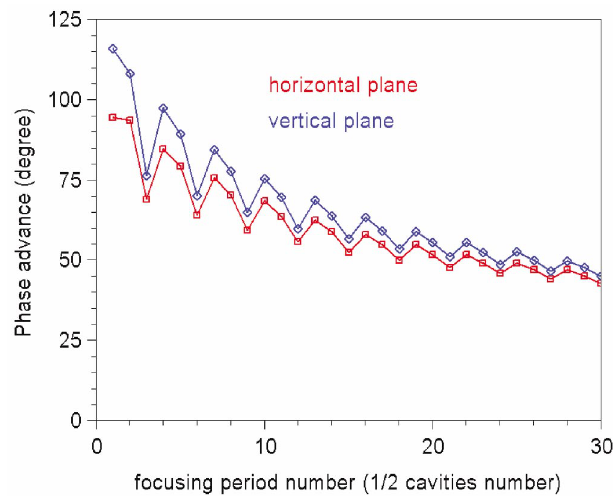
FIG. 15. (Color) Transient factor vs relative velocity for the first version of cavity-cavity matching.